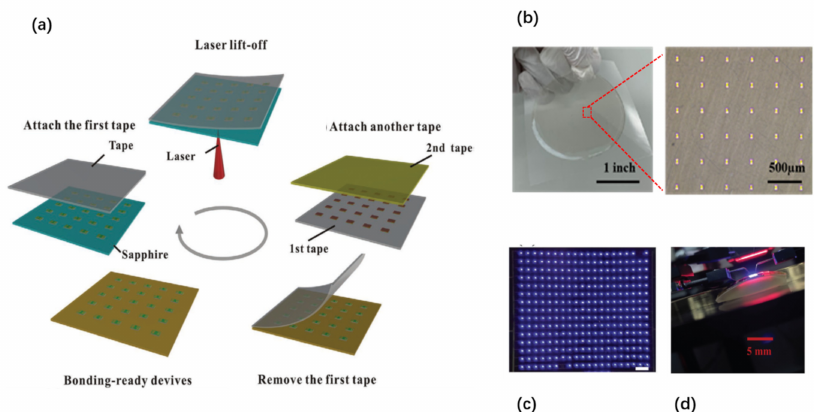
Figure 17. ( a ) Working principle of the tape-assisted laser transfer, ( b ) images of wafer-level micro- LED chips via tape-assisted laser transfer (TALT), ( c ) a planar display device, and ( d ) a flexible display device developed based on TALT. Adapted with permission from [118]. Copyright John Wiley and Sons,